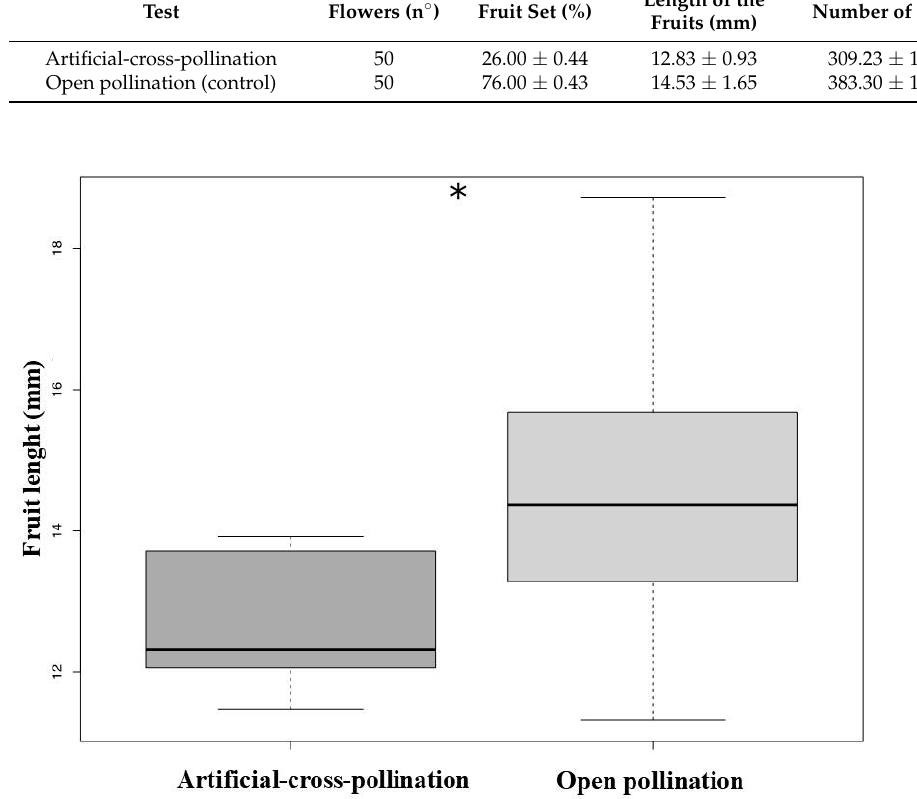
Figure 5. The fruit length produced from natural pollination experiment was significantly bigger compared to fruits of manual treatment (* p < 0.005). Table 2. Fructification rate, average (±standard deviation), number of seeds and average (±standard deviation) size length of the fruits obtained from open pollination and artificial-cross- pollination treatments in Ludwigia nervosa .